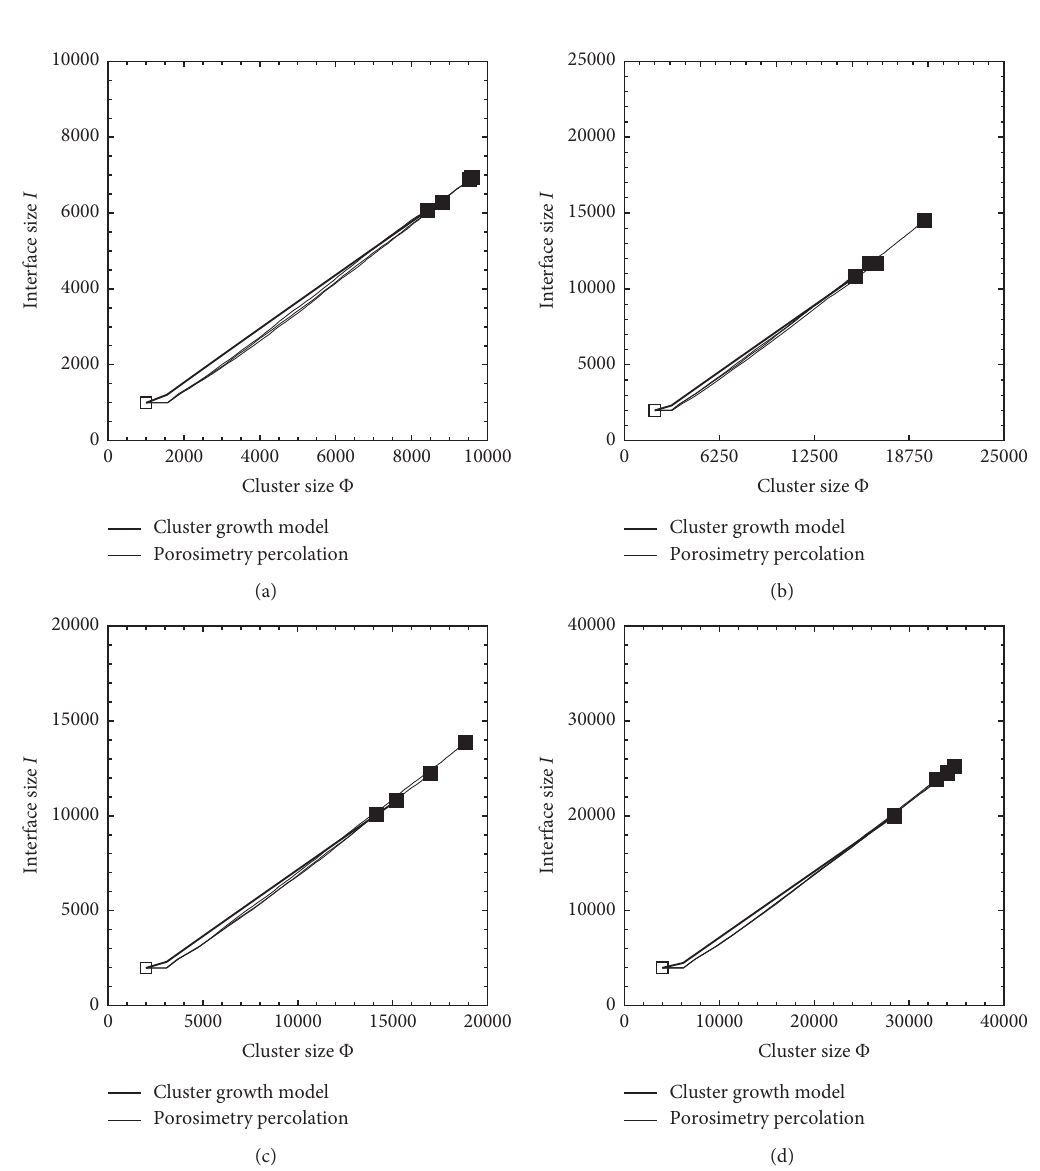
Figure 13: Calculated and simulated evolutions on the ( Φ , I ) plane for the following cases: 1-sided invasion of lattices having (a) L � 1000 � 1000, I � 1000), (b) L � 2000 ( Φ � 2000, I � 2000), and 4-sided invasion of lattices having (c) L � 500 ( Φ ( Φ 0 0 0 0 L � 1000 ( Φ � 3996, I � 3988). The thick lines show the evolution of the cluster growth model; the thin lines are evolutions computed with 0 0 individual porosimetry percolation simulations. The empty squares and full squares correspond to the starting and fully evolved clusters,